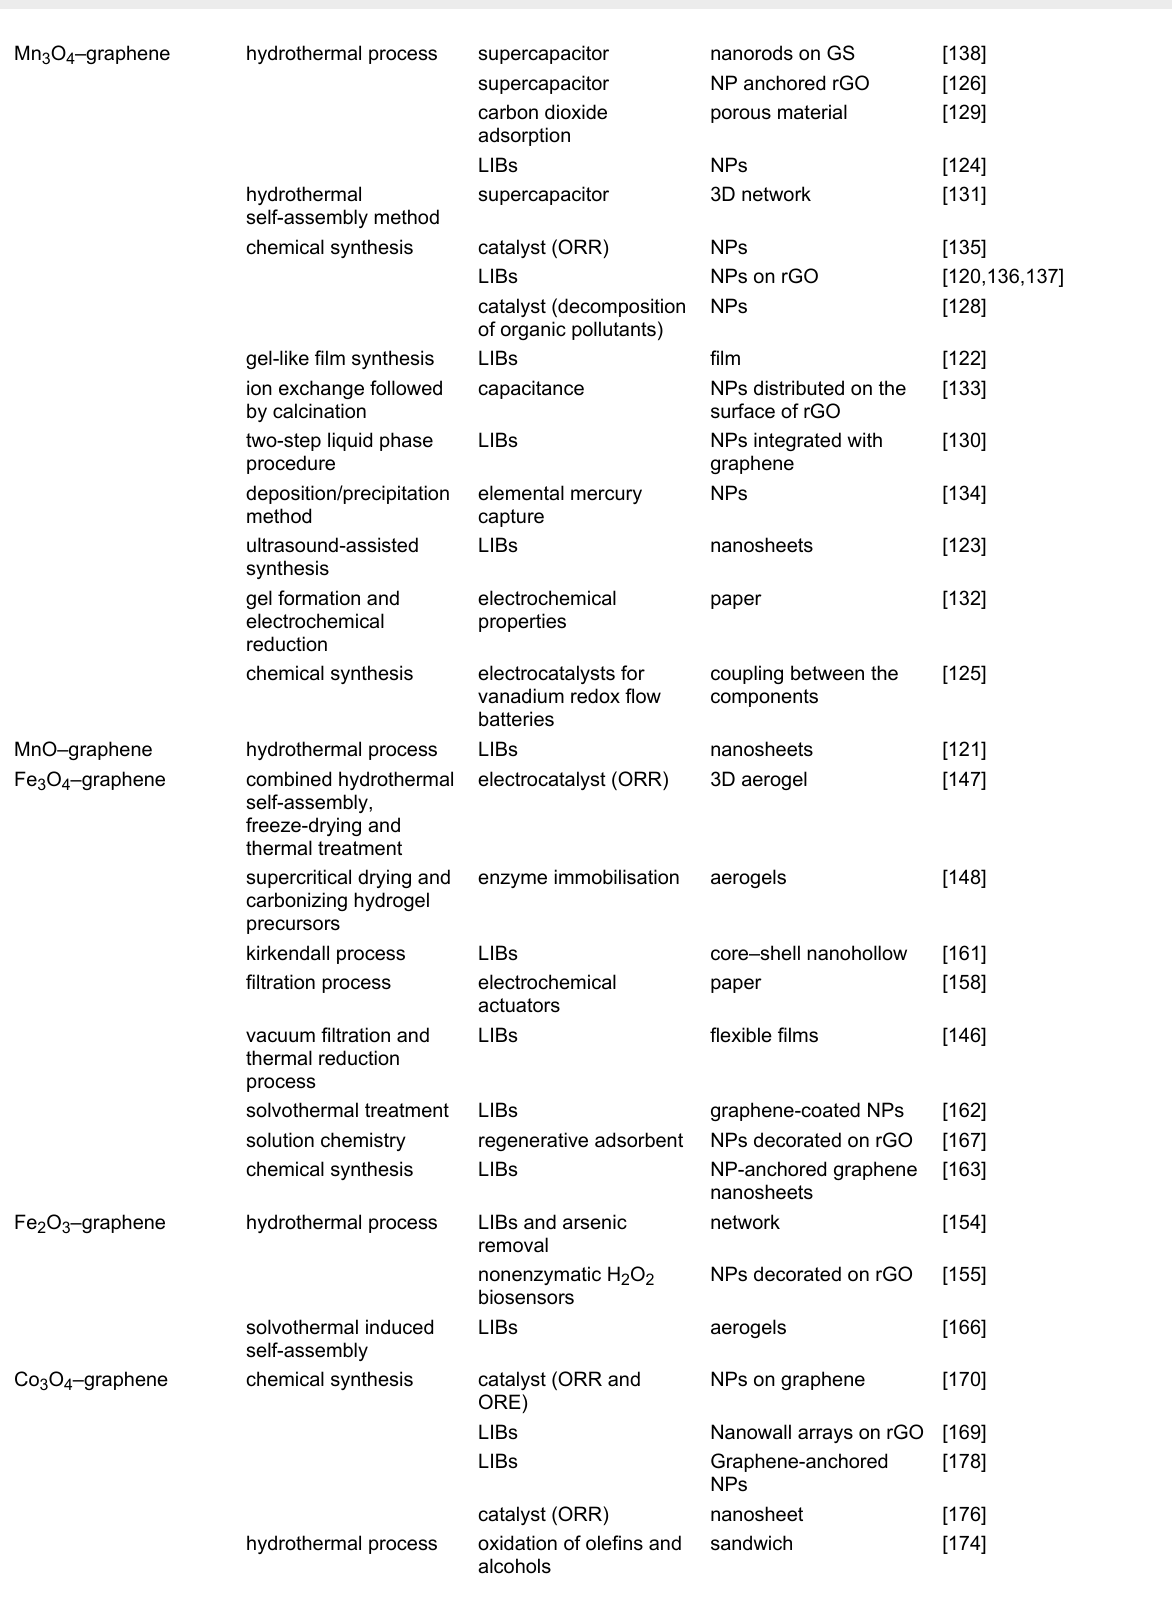
Table 1: Important hybrid material synthesis procedures and their potential applications.